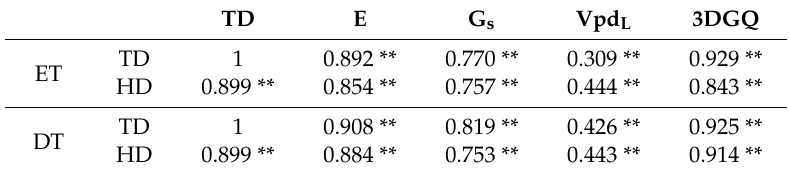
Table 4. Spearman correlation analysis of each parameter and cooling and humidifying e ff ects. TD E G s Vpd L